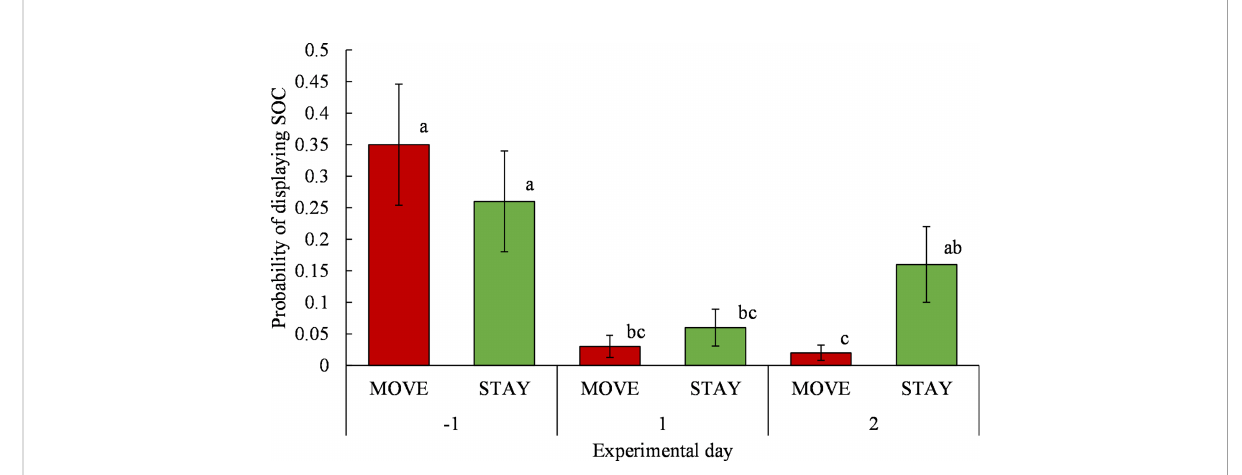
FIGURE 4 Probabilities of displaying social play (SOC) in pigs moved to a weaner pen (MOVE; red bars) or kept in the farrowing pen (STAY; green bars) after weaning, between 14:00 h and 22:00 h on days − 1, 1, and 2 relative to weaning. The bars represent probability, and the error bars indicate standard error. Estimates and standard error bars were back-transformed from the model using the inverse link function. Different superscript letters indicate statistical difference at p < 0.05 both between and within days.